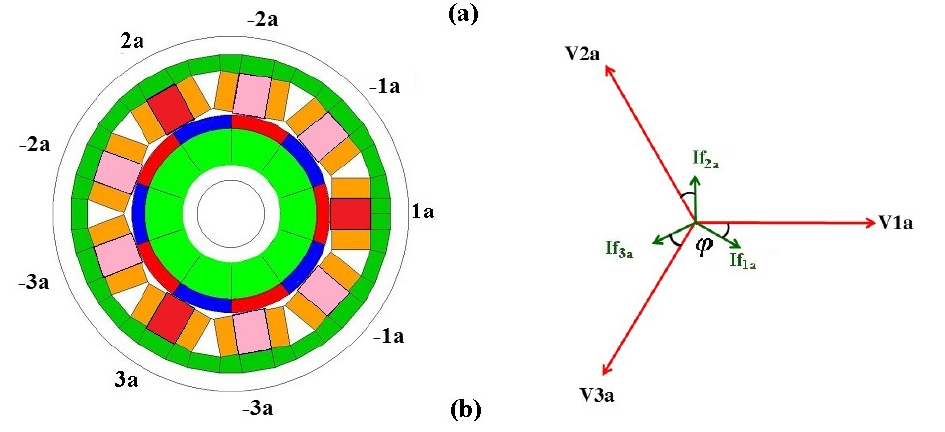
Figure 1. Case I : base machine ( a ) and phasor diagrams ( b ). Red stator teeth are the axes of the coil supplied by the converter a . ϕ is the V-I phase angle.